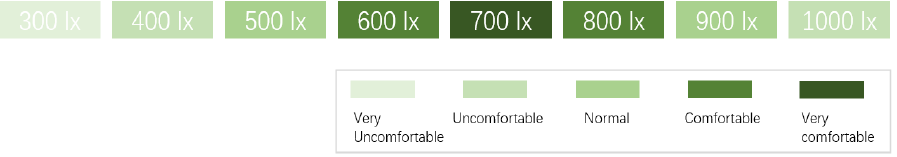
Figure 13. Schematic of illumination value and comfort